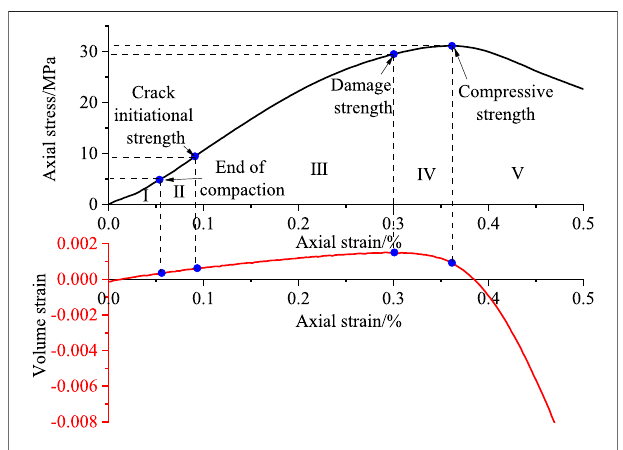
FIGURE 6 | Axial stress-strain curve and volumetric strain curve of sample S-1 under uniaxial compression.